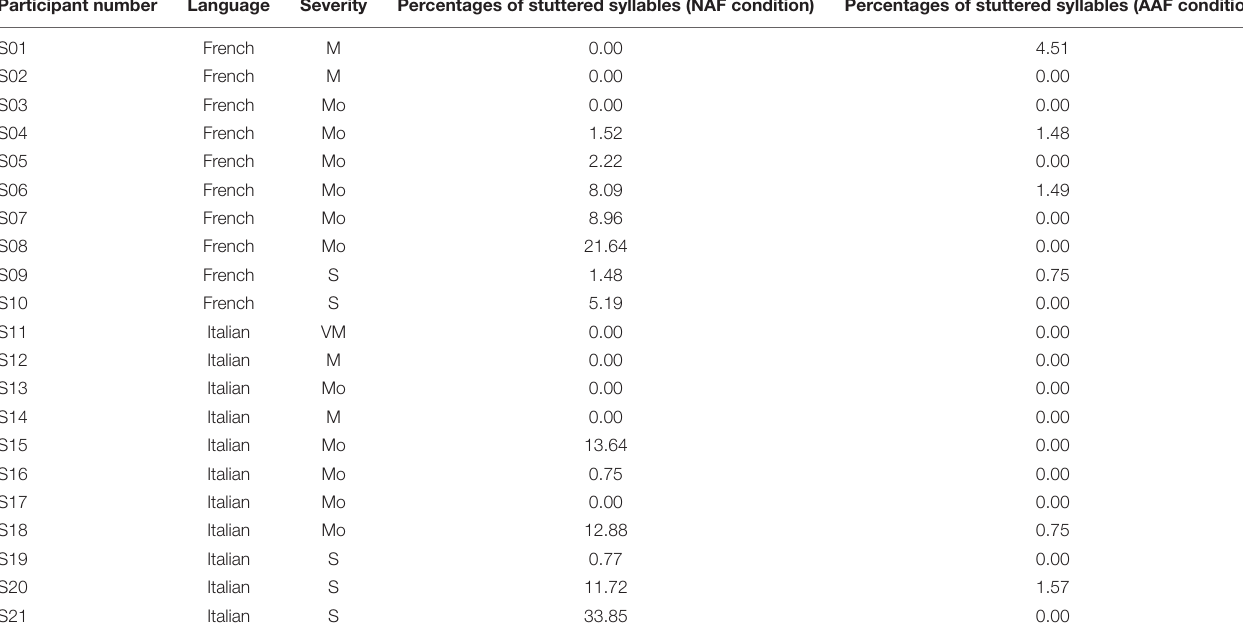
TABLE 4 | Language, Stuttering Severity (according to SSI-3), and measured percentages of stuttered syllables under NAF and AAF condition for each PWS. Participant number Language